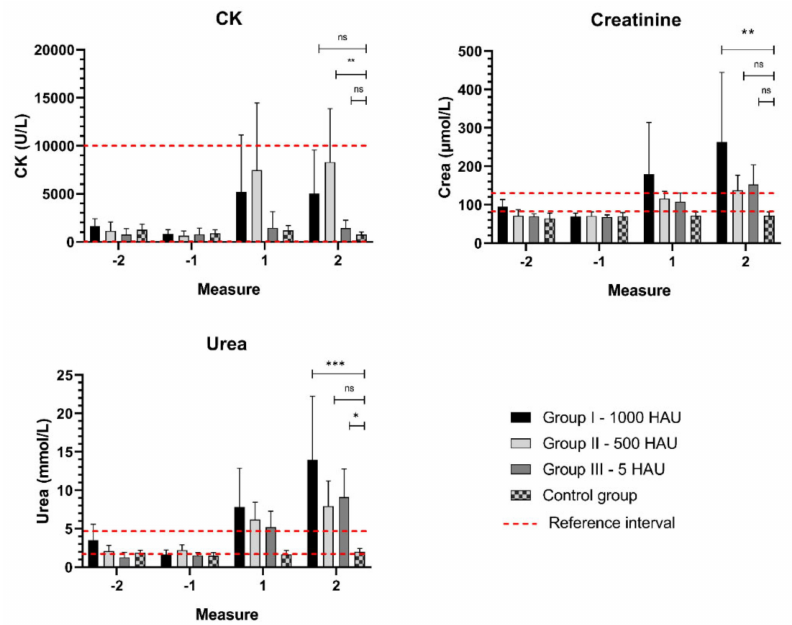
Figure 4. Mean parameters of the kidney profile. Measurements: − 1, − 2 - two measurements before viremia, 1,2 - the last two days of life with viremia. CK - creatine kinase; ns - statistically insignificant; *,**,*** - statistically significant, respectively; p < 0.05, p < 0.01, and p < 0.001. Error bars indicate standard